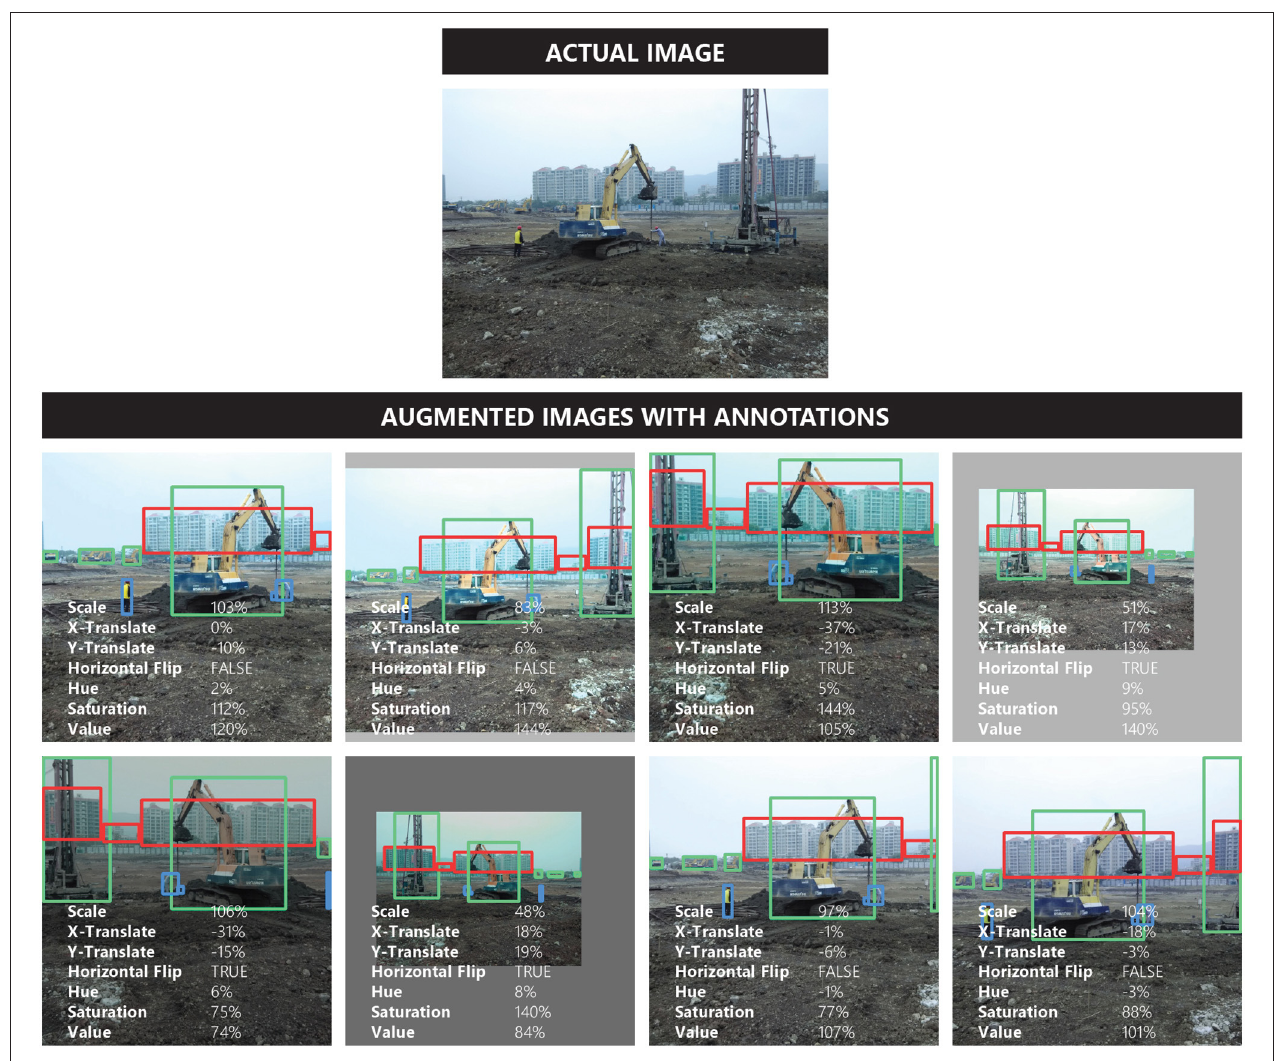
FIGURE 8 | Example of actual and randomly augmented